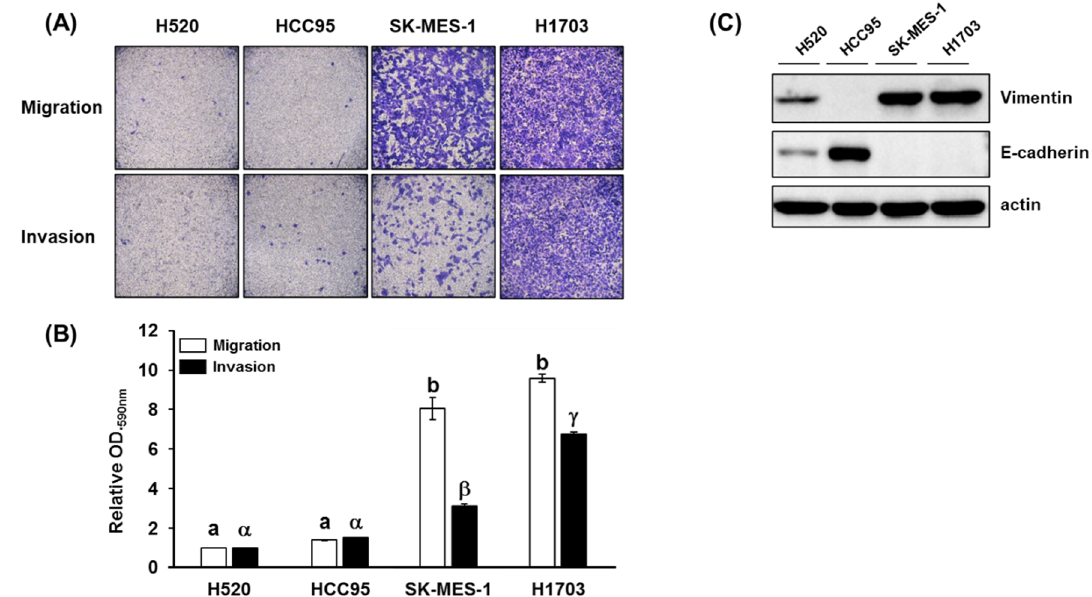
Figure 1. Migration and invasion properties of different lung squamous cell carcinoma (SQCC) cell lines: ( A ) representative images of cell migration and invasion in the four investigated lung SQCC cell lines; ( B ) quantified data (mean ± SEM) from three independent experiments demonstrating the migration and invasion potential of the four lung SQCC cell lines tested; ( C ) expression of vimentin and E-cadherin of four lung SQCC cell lines. The actin was used as a loading control. Images of the migrated- or invaded-cells were taken at × 100 magnification under a bright-field microscope. Different letters, (a, b, and c) and ( α, β, and γ ), indicate statistically significant differences of migration and invasion levels among lung SQCC cells ( p < 0.01). Uncropped blot image for each antibody is presented in Figure. S4.